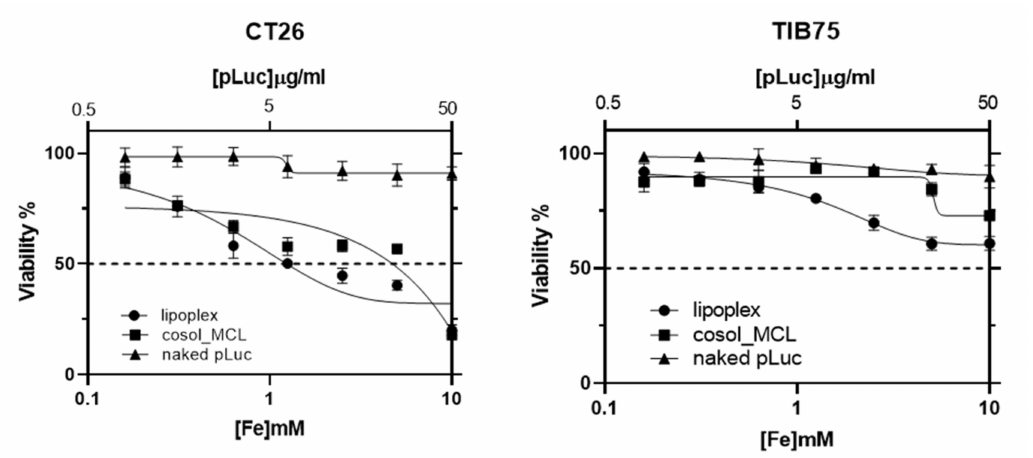
Figure 18. Viability of CT26 (colon cancer) and TIB-75 (hepatocyte) cells after 24 h incubation with naked plasmid DNA (pFAR4-luc), cosol_MCLs, or lipoplexes (RC8). CT26 or TIB75 cells were seeded at 2 × 10 4 cells / well in a 96 well plate. Alamar blue test was carried out 24 h after incubation of cells with 100 µ L of lipoplexes based on cosol_MCLs or cosol_MCLs or naked pFAR4-luc containing various concentration of pFAR4-luc and MNPs. The data given are the averages of 2 di ff erent experiments performed in triplicates ( n = 6); bars,